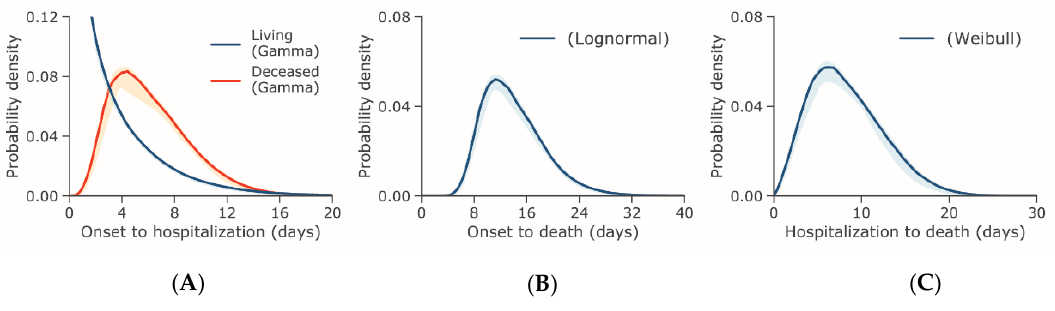
Figure 1. Probability distributions of the time from illness onset or hospital admission to hospital admission or death for COVID-19 outbreak cases reported through 31 January 2020. ( A ) Probability density of the time from illness onset to hospital admission in days set to the best-fit gamma distribution. ( B ) Probability density of the time from illness onset to death in days set to the best-fit lognormal distribution. ( C ) Probability density of the time from hospital admission to death in days set to the best-fit Weibull distribution.